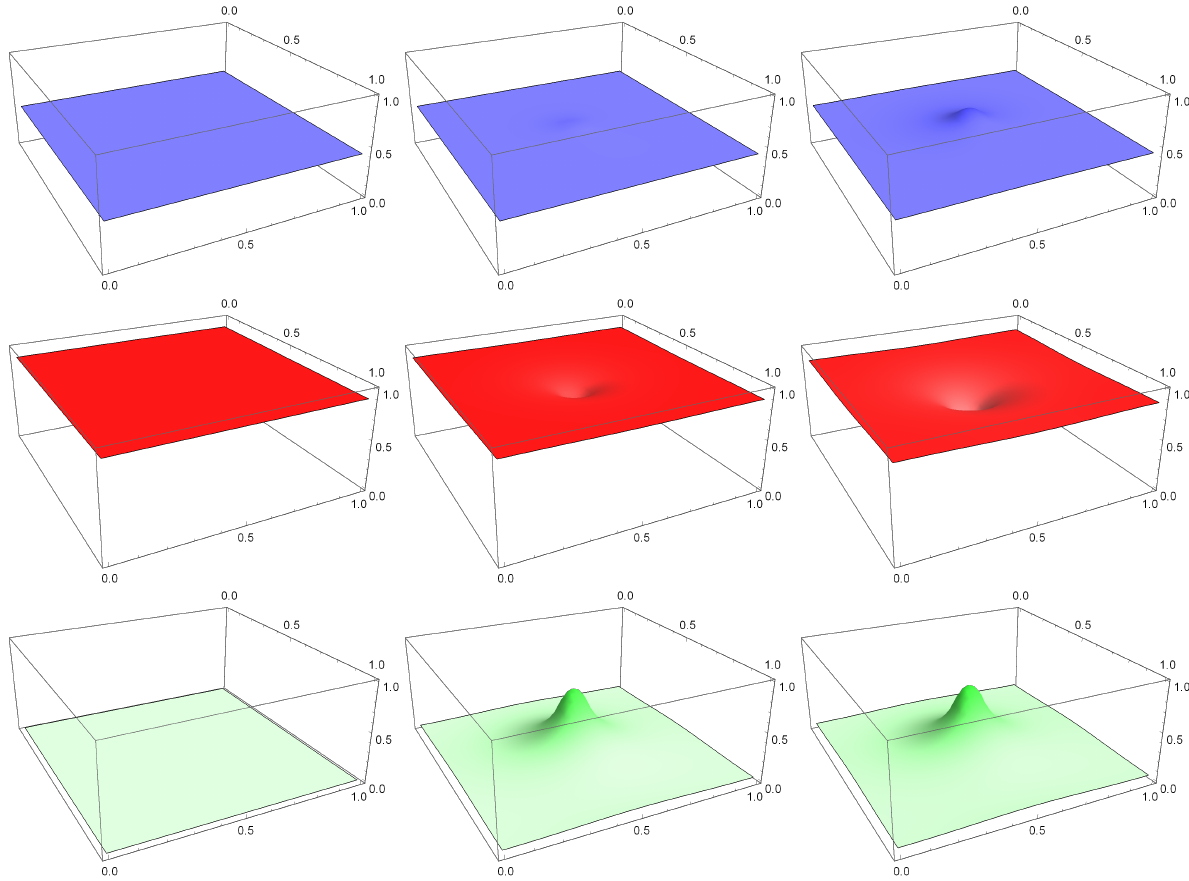
Fig. 1 Results of Simulation 1, for model (1.1) within a two-dimensional domain Ω = [ 0 , L ] × [ 0 , L ] = [ 0 , 1 ] × [ 0 , 1 ] . Plots of model solutions N ( x , y , t ) (normal cells, blue, top row), A ( x , y , t ) (cancer cells, red, middle row) and D ( x , y , t ) (chemotherapeutic drug concentration, green, bottom row) at time points t = 0 , 1 , 15 (columns 1,2 and 3, respectively). See Table 1 for parameter values used here. At time t = 0, the tumor is spread trough the tissue, and as chemotherapy